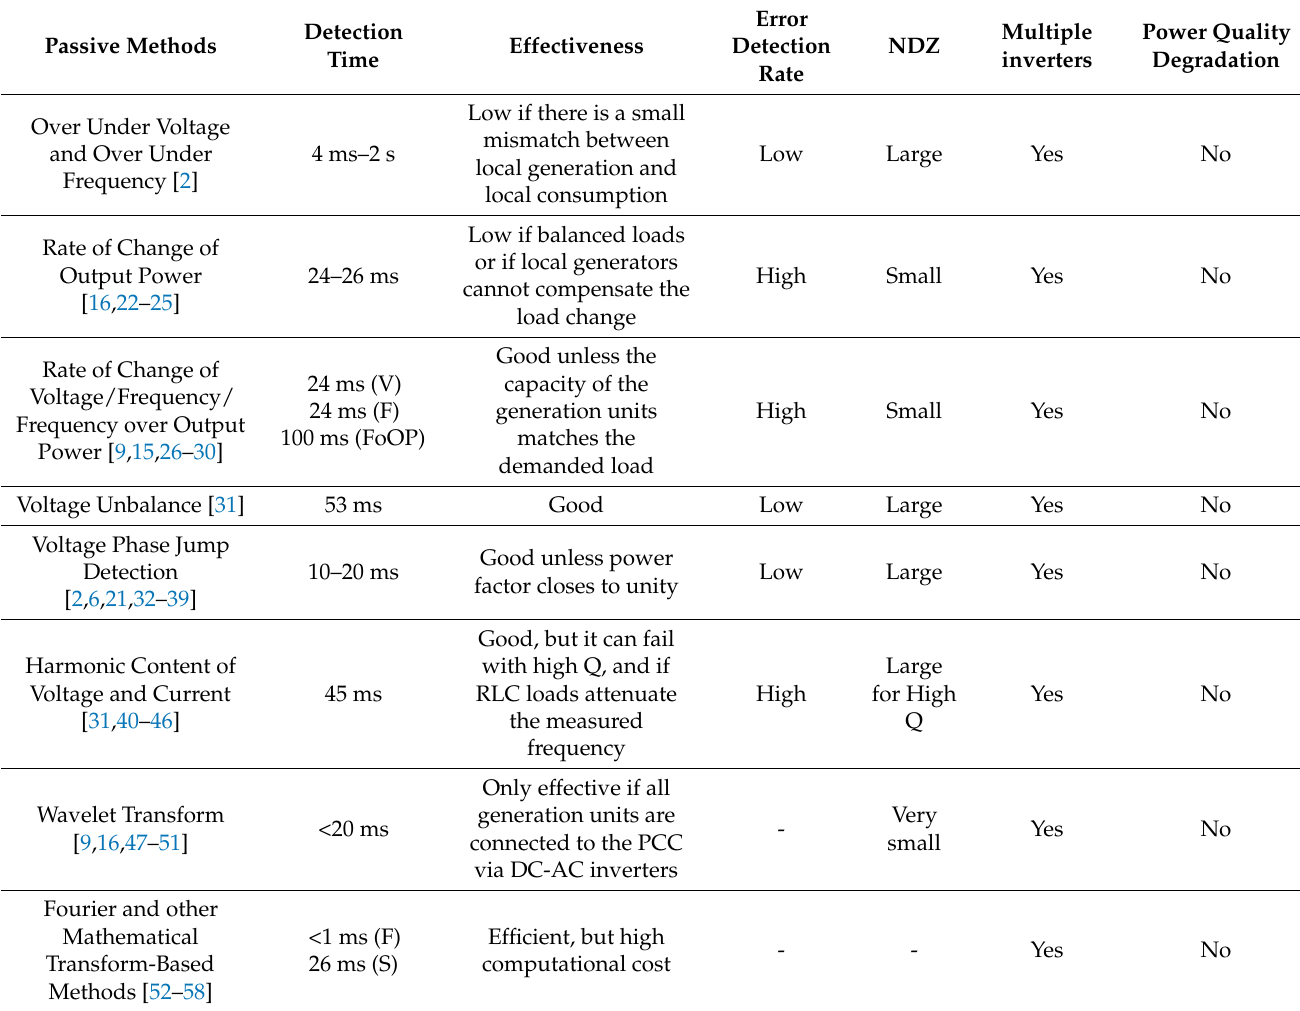
Table 1. Resume of the passive islanding methods presented in this document.